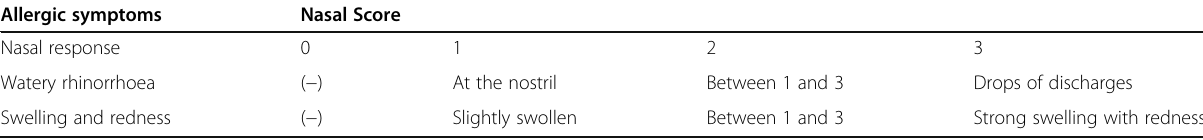
Table 1 Criteria for grading the severity of TDI-induced nasal responses in mice Allergic symptoms Nasal Score Nasal response 0 1 2 3 Watery rhinorrhoea ( − ) At the nostril Between 1 and 3 Drops of discharges Swelling and redness ( − ) Slightly swollen Between 1 and 3 Strong swelling with